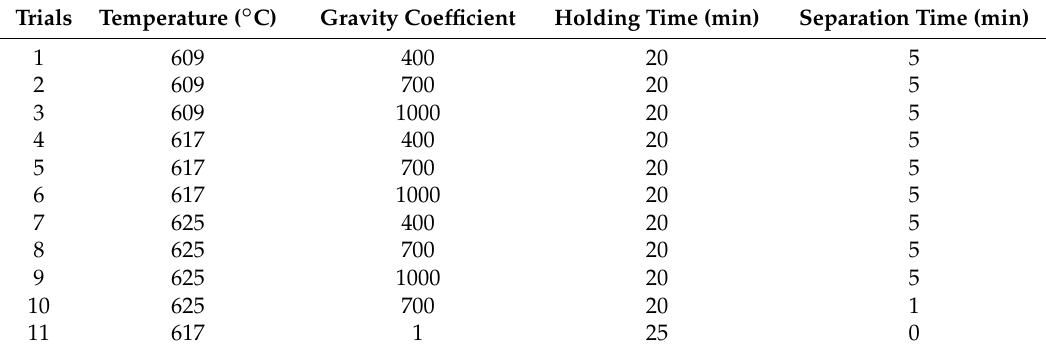
Figure 1. Sketch map of the super-gravity rheorefining apparatus.